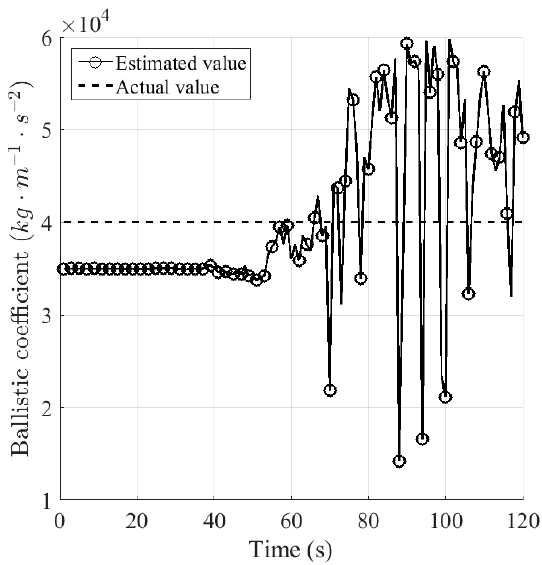
Figure 10. Estimated value of the ballistic coefficient for sensor S 2 .